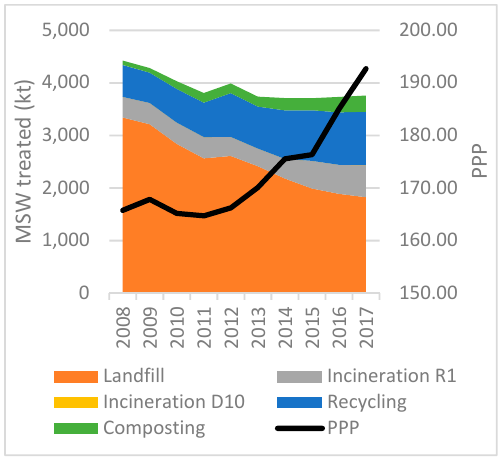
Figure 34. Waste treatment methods and PPP in Hungary 2008–2017 (European Statistics 2019b, 2019c).